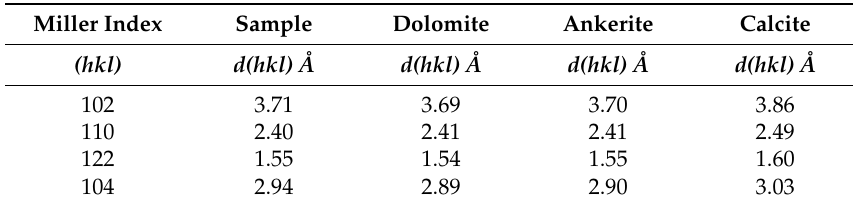
Table 3. Comparison of the lattice parameters of dolomite synthesized with microbes and standard dolomite and ankerite